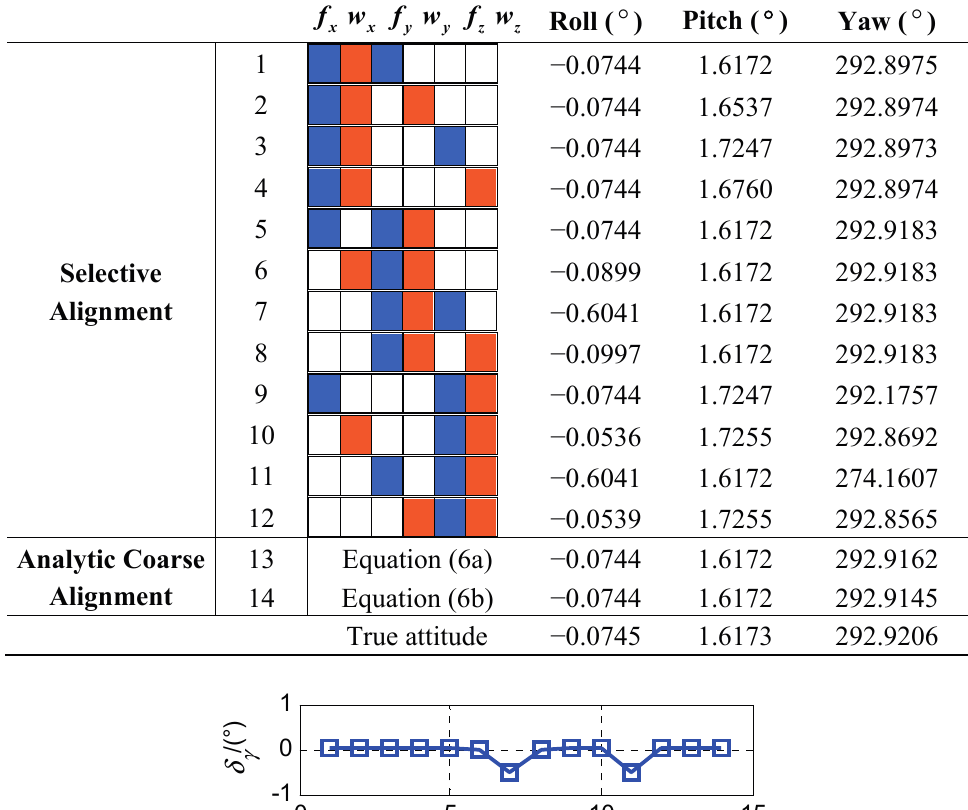
Table 6. The attitude angles obtained using AA methods.